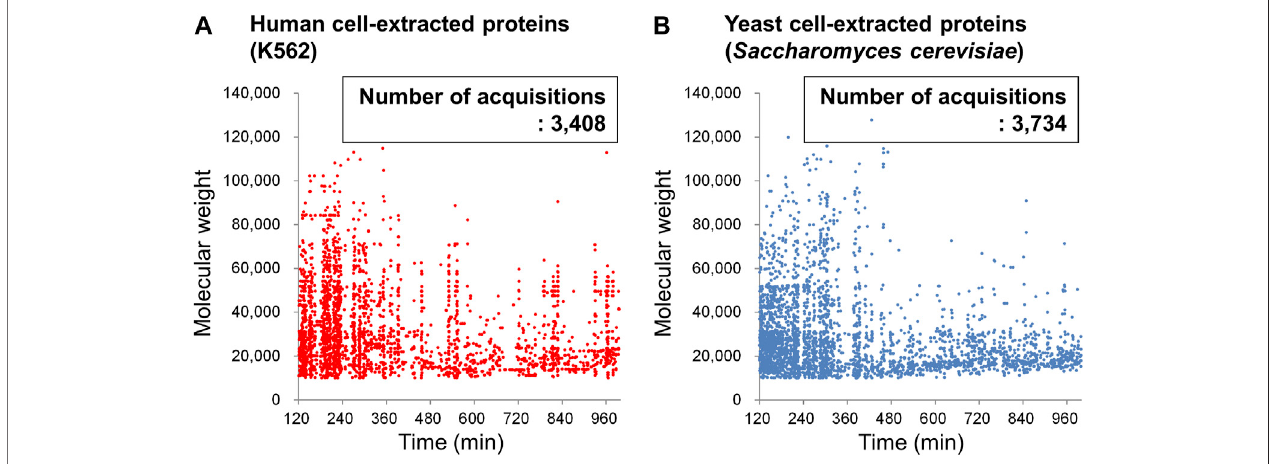
FIGURE12| PlotsofthedeconvolutedmolecularweightofDAABD-labeled (A) human(K562)cell – extractedproteinsand (B) yeastcell – extractedproteinsagainst elution time on the nano- fl ow FD-LC/MS system.